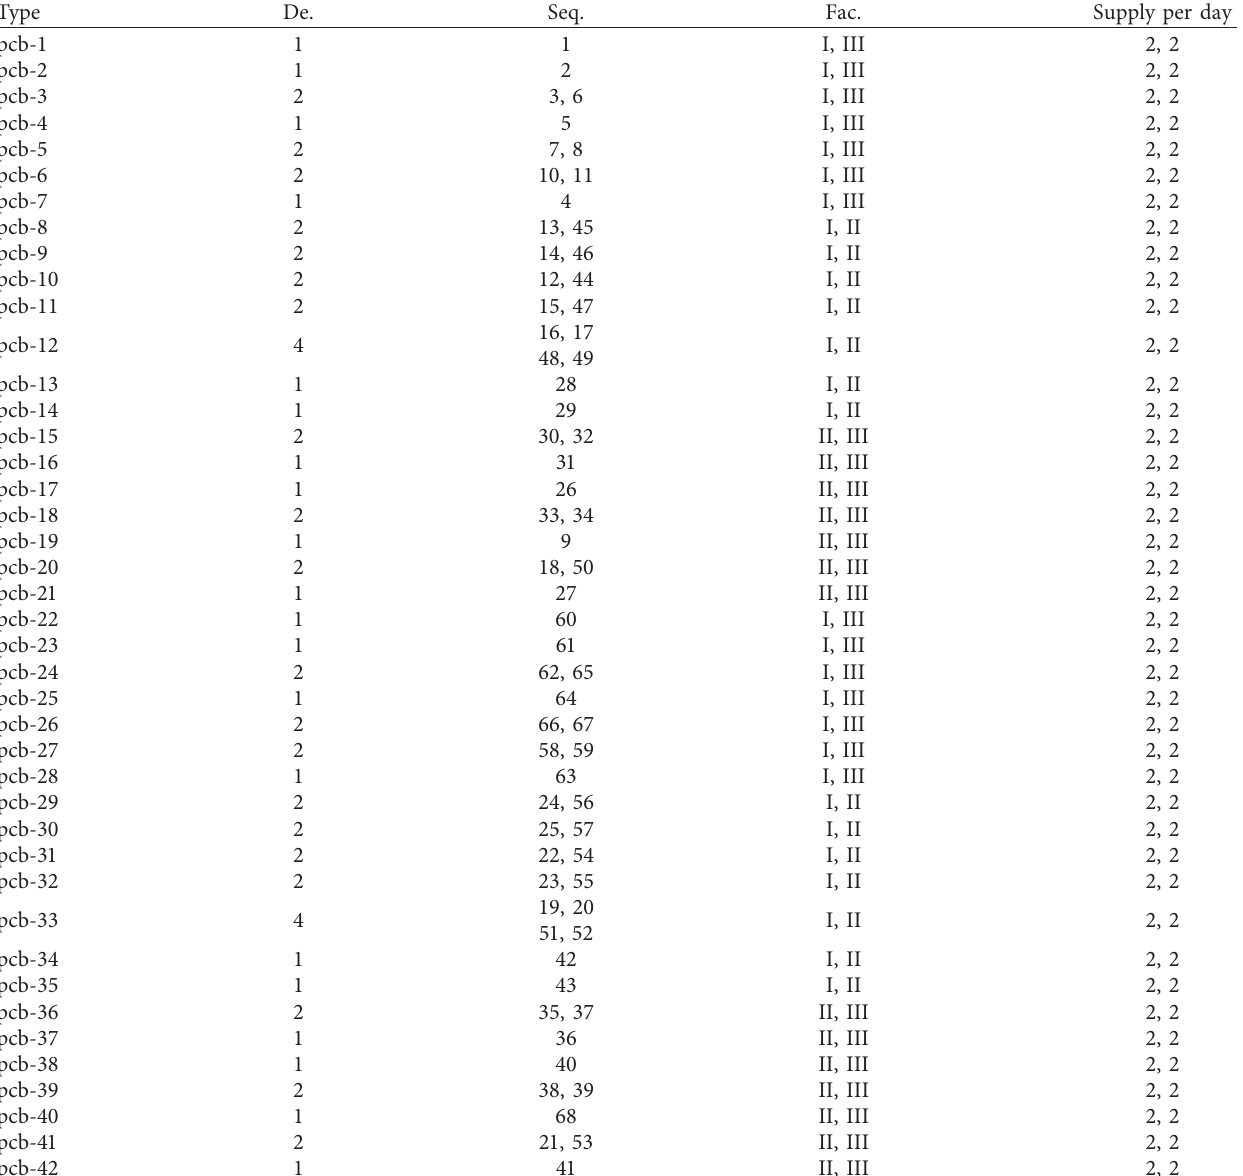
Table 1: Demand and supply of PC components for the construction of a standard floor.